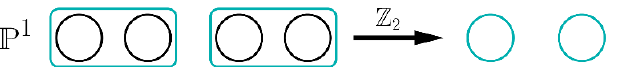
Figure 3. Schematic description of the action (cid:0) on the 4 curves in the curve class of the (cid:12)rst P 1 . whether the four polynomials d j are linearly dependent, that is, whether there are k j 2 C , independent of the bundle moduli a k ; b k ; c k , such